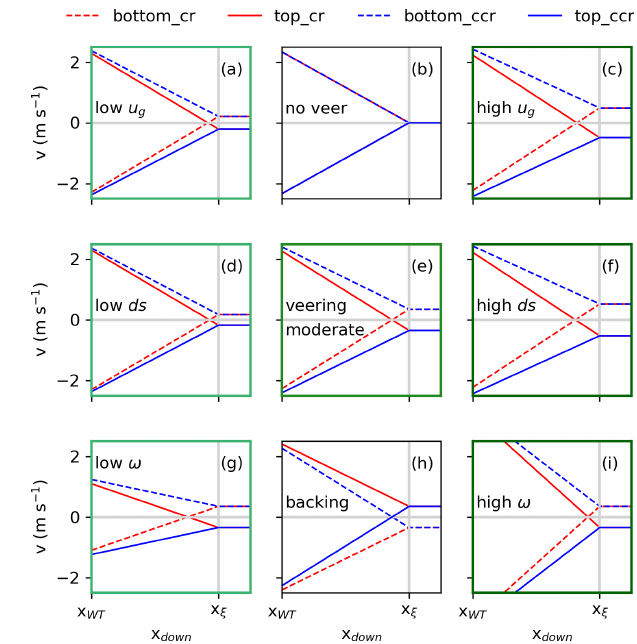
Figure 2. Representations of v ( z = 75m ,x down ) at the rotor cen- ter in lateral position as bottom and v ( z = 125m ,x down ) as top (Eq. 17) for a clockwise-rotating (cr) and a counterclockwise- rotating (ccr) rotor in the case of no veer in (b) , a veering wind in (e) , and a backing wind in (h) . In the case of a veering wind in (e) , moderate parameters of u g = 10ms − 1 , ds = 0.08 ◦ m − 1 , and ω = 0.12 ◦ s − 1 are applied. In the left (a, d, g) and right (c, f, i) column, only one parameter is changed compared to the veering- wind situation in (e) . Applying low parameters, u g = 6ms − 1 in (a) , ds = 0.04 ◦ m − 1 in (d) , and ω = 0.058 ◦ s − 1 in (g) , and applying high parameters, u g = 14ms − 1 in (c) , ds = 0.12 ◦ m − 1 in (f) , and ω = 0.175 ◦ s − 1 in (i)